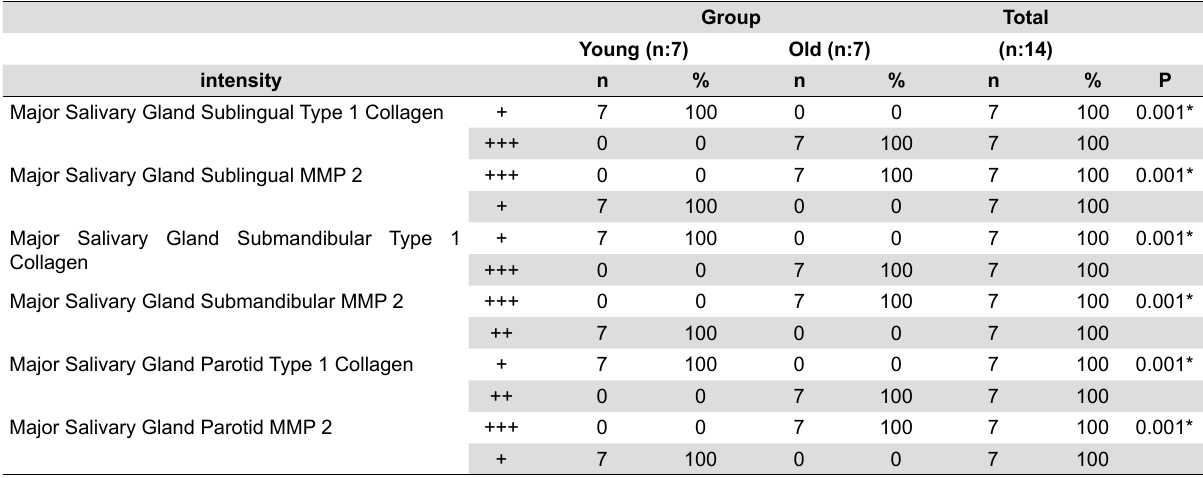
Figure 3- Immunreactivity of type I collagen protein in major salivary gland, 40X. A) Parotid gland of young mice; B) Parotid gland of old mice; C) Sublingual gland of young mice; D) Sublingual gland of old mice; E) Submandibular gland of young mice; F) Submandibular gland of old mice; *Red arrow: Collagen Table 2- Comparison of immunreactivity of young and old mice